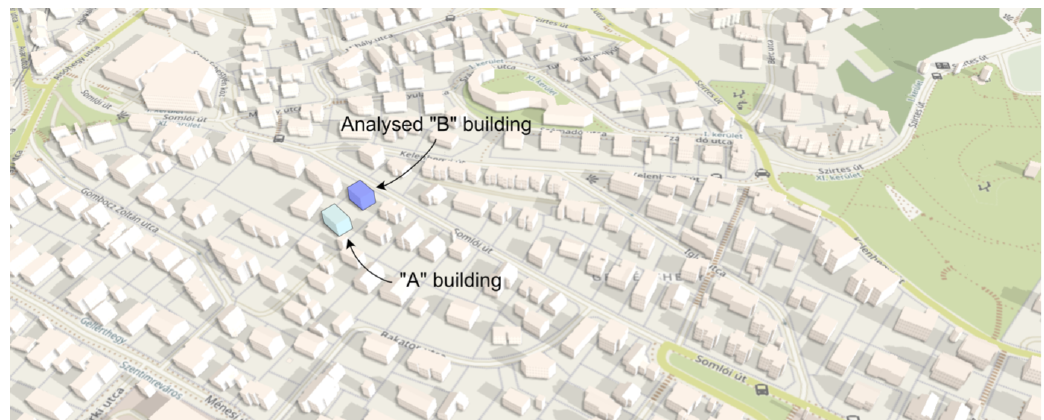
Figure 1. Monitored building’s location (Building “B” is the subject of this study) [16].